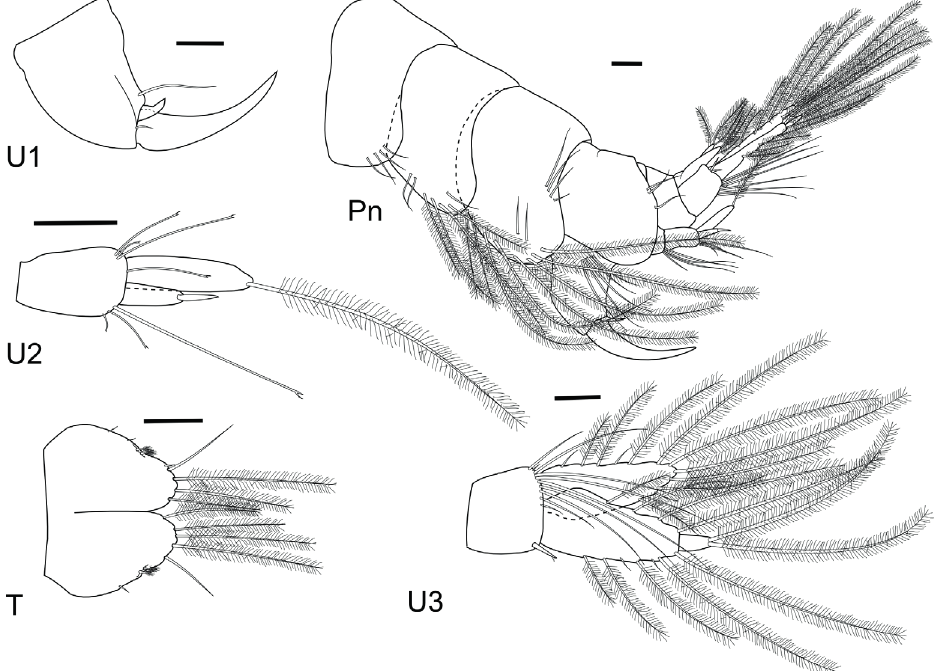
Figure 7 - Puelche irenae sp. nov. Male, 5.3 mm, MNRJ 28808: Uropods, pleon and telson. Scales = 0.1